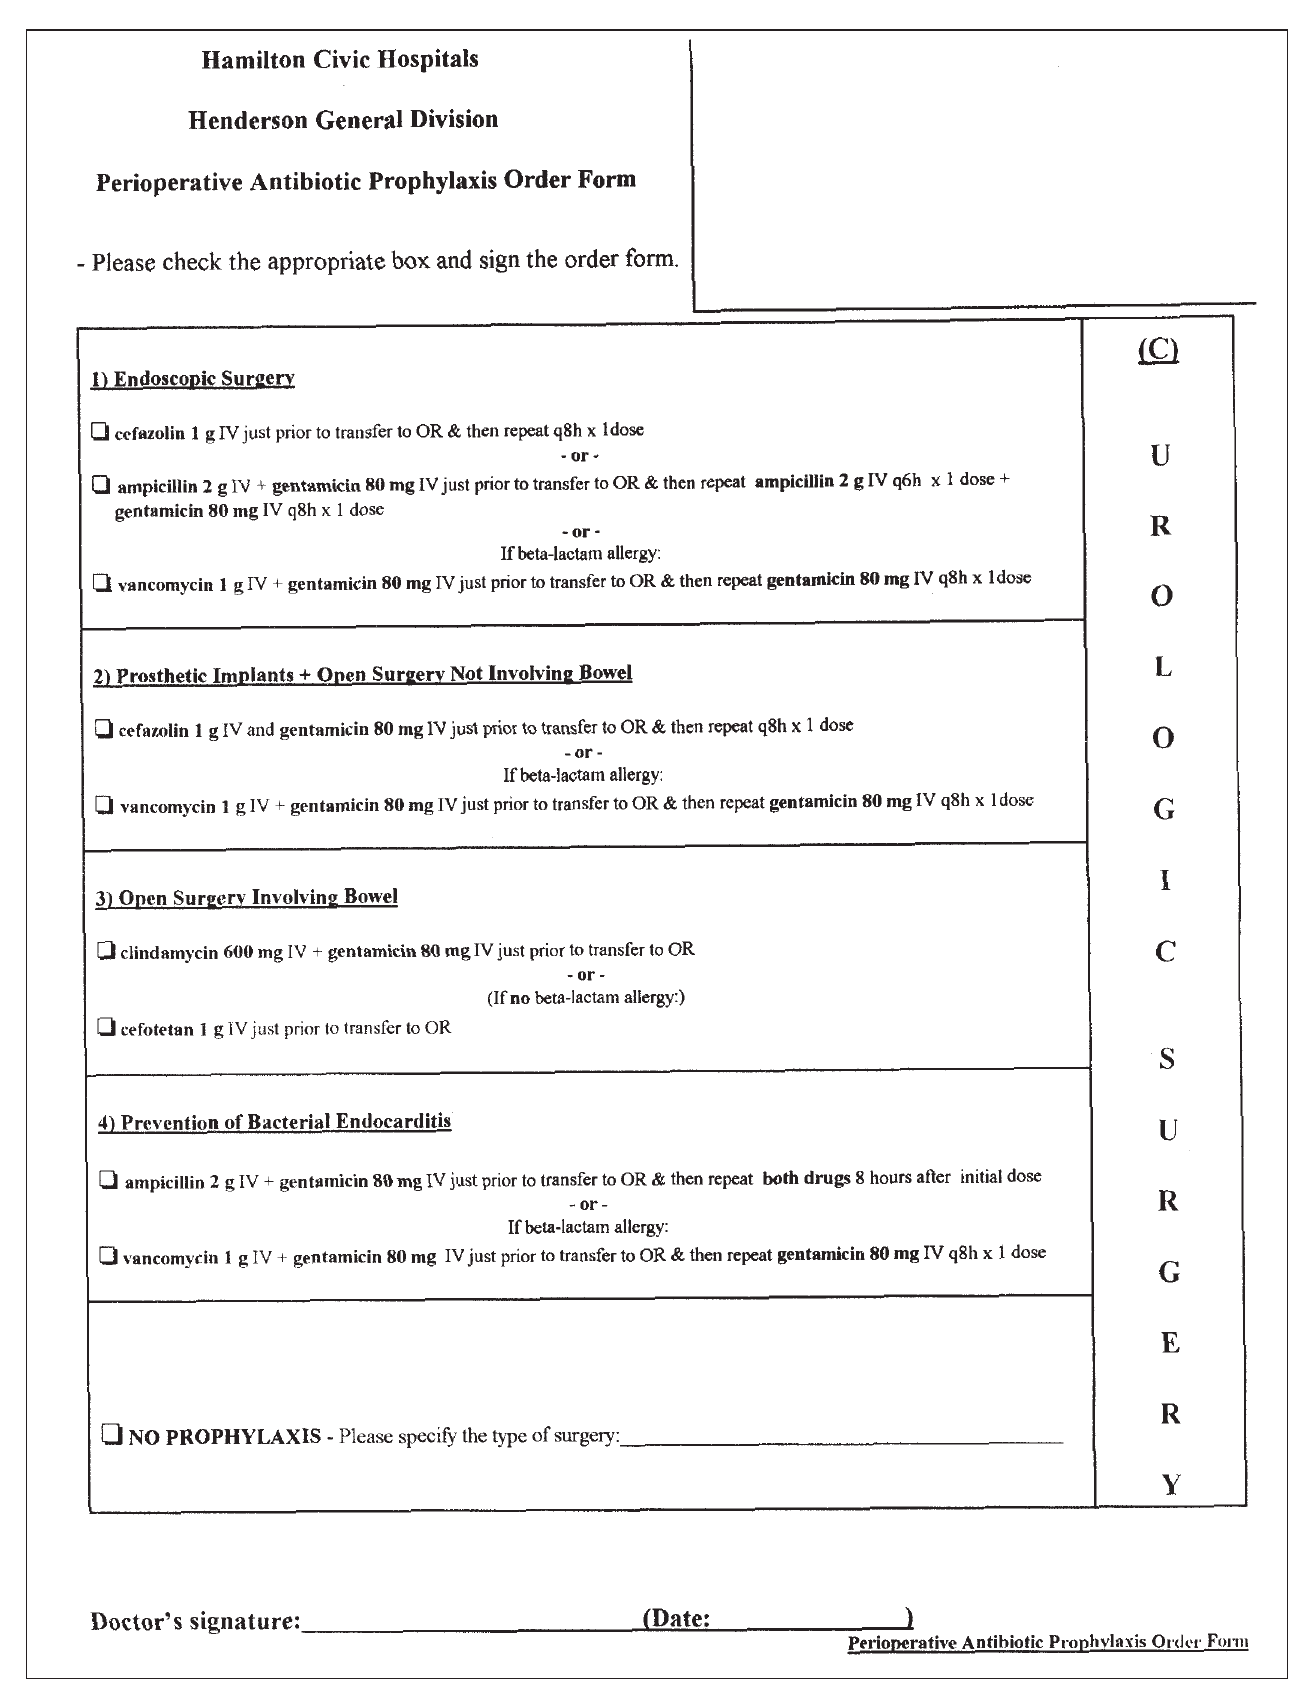
Color profile: Disabled Composite Default